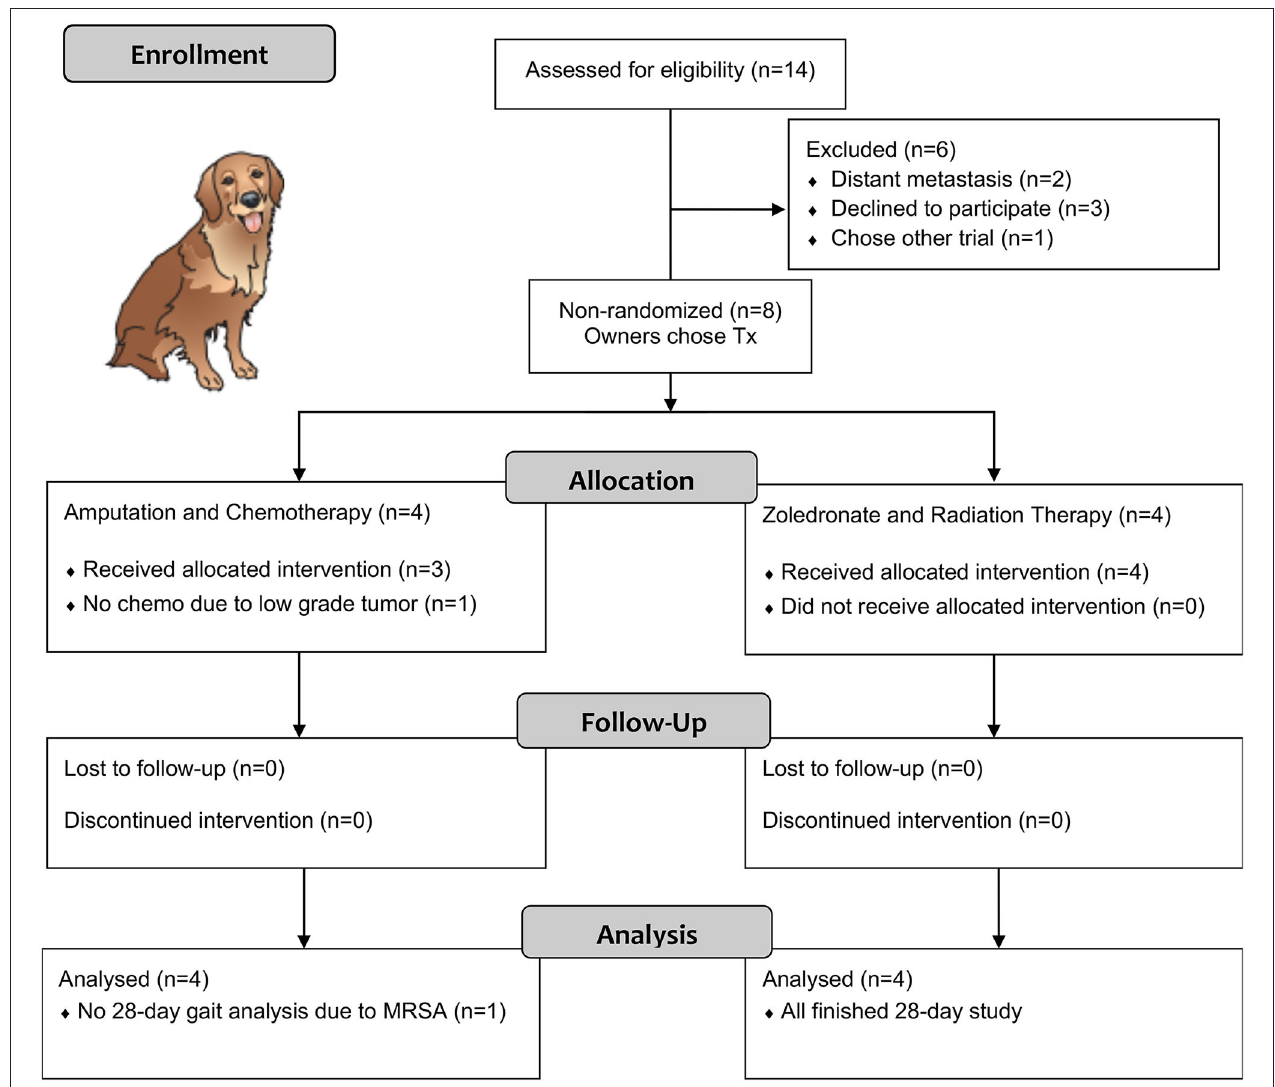
FIGURE 1 | CONSORT diagram of cases in our pilot